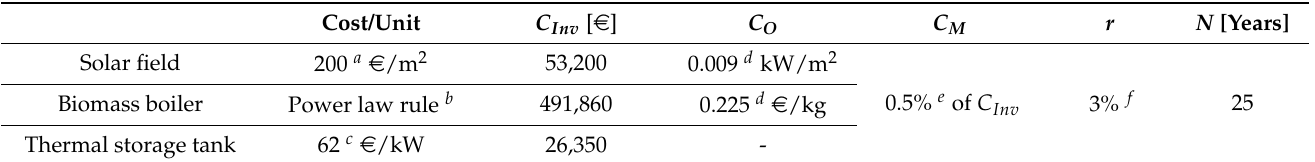
Table 4. The purchase prices considered for each device, the investment costs of the solution delivered by the algorithm, the operating and maintenance costs, the discount rate, and the life time of the plant. The values reported in the last three rows are used for the three devices, i.e., the solar field, biomass boiler, and thermal storage